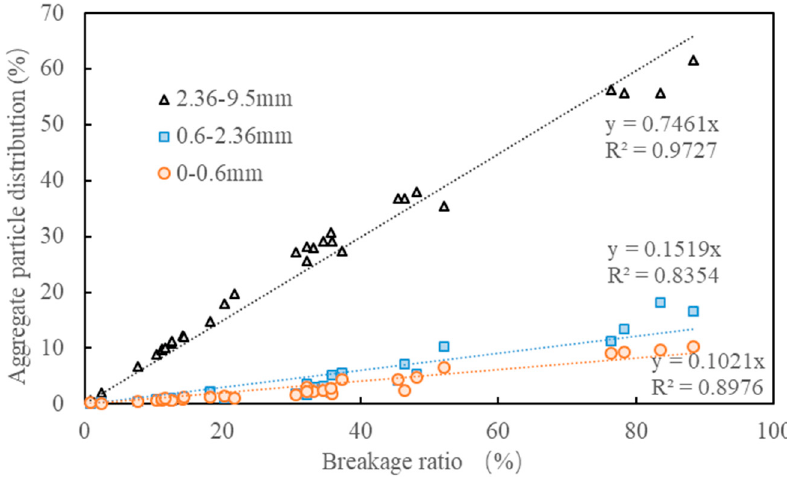
Figure 16. Relations between the breakage ratio and aggregate particle distribution.